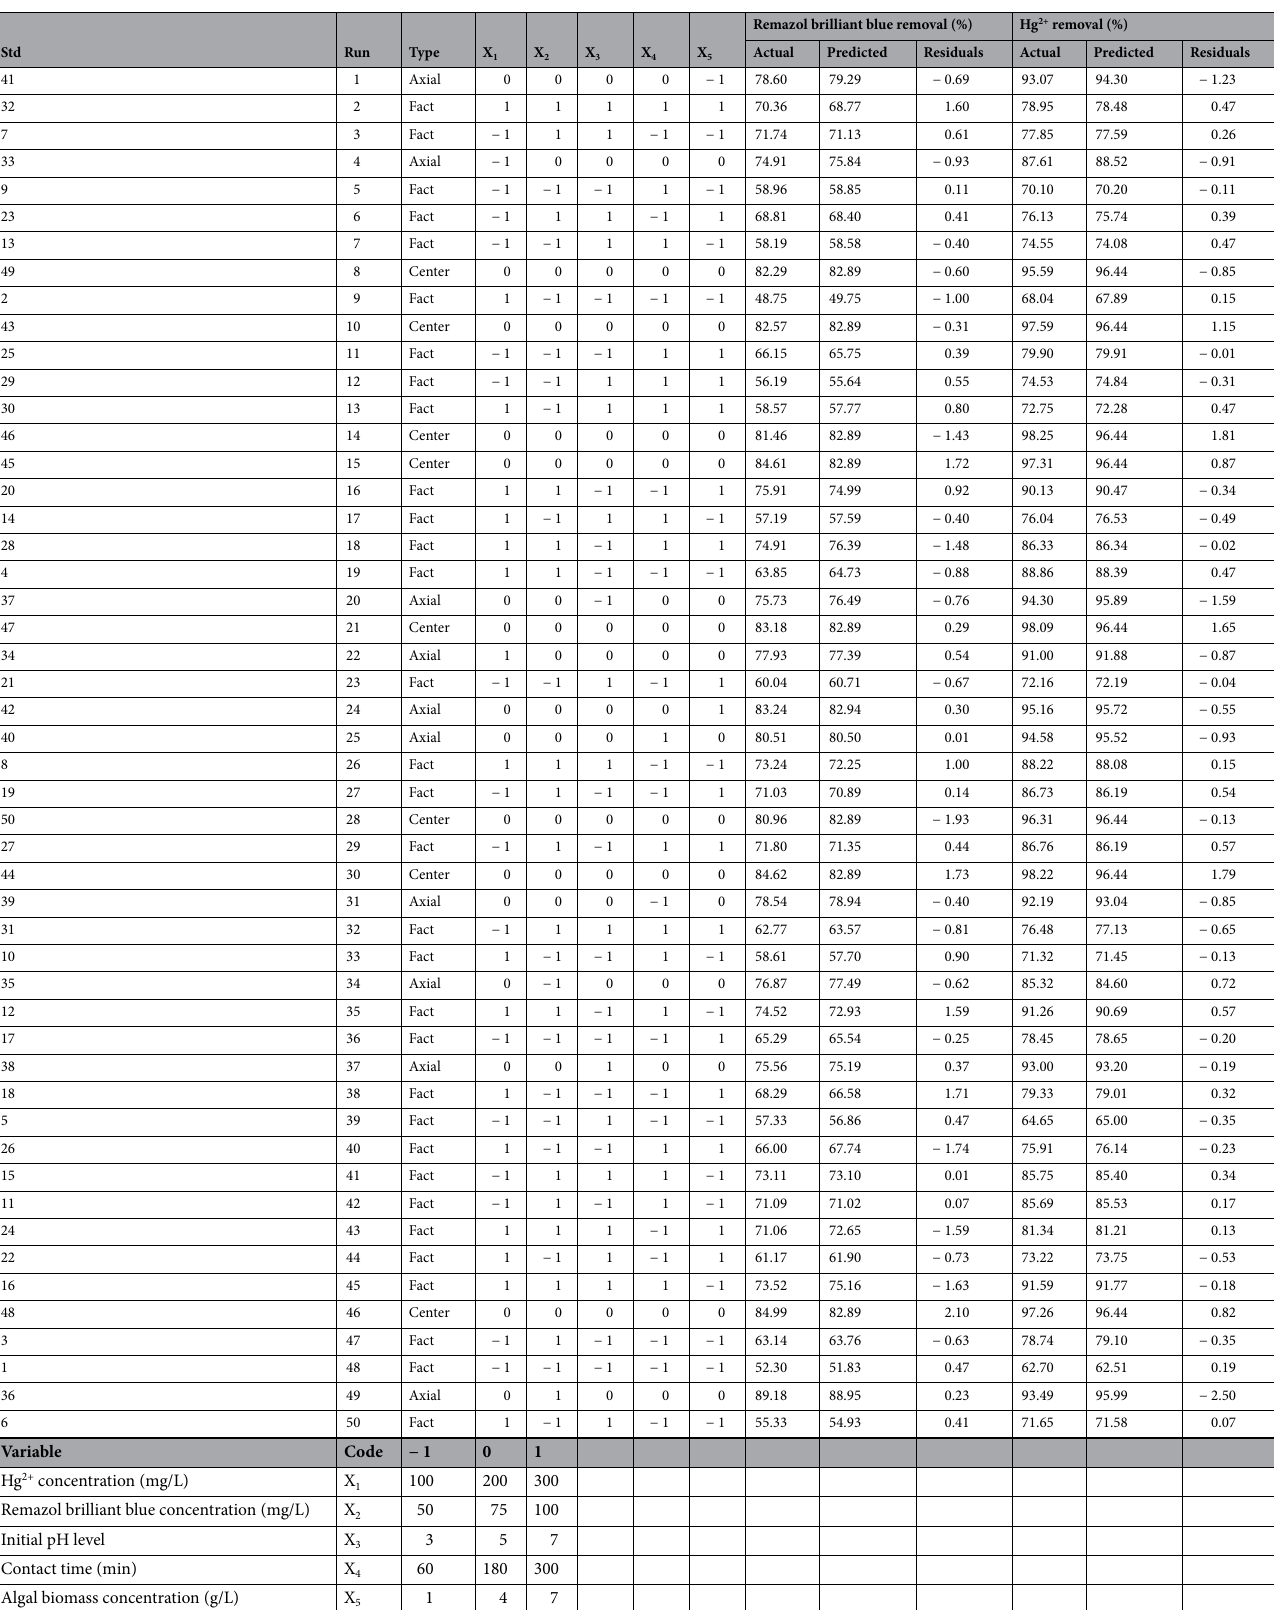
Table 1. FCCCD matrix mean actual and predicted values of simultaneous biosorption of Hg 2+ and Remazol brilliant blue dye by using Gelidium corneum